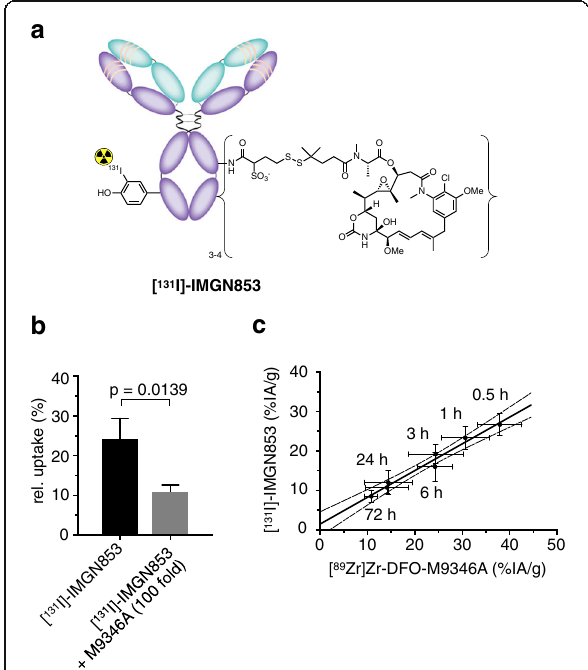
Fig. 4 Pharmacokinetic head-to-head comparison between antibody-drug-conjugate, IMGN853 and companion diagnostic, [ 89 Zr]Zr-DFO-M9346A. a Introduction of the radionuclide I-131 by direct halogenation of the antibody in the presence of Iodogen as chemical oxidant yielding radiolabeled antibody-drug-conjugate [ 131 I]-IMGN853 (32.2 MBq, 0.87 mCi, 250 μ g) in high radiochemical purity (> 98%). b In vitro characterization of [ 131 I]-IMGN853. Incubation of KB cells with radiolabeled ADC or with a mixture of radiolabeled ADC (100 ng) and M9346A (10 μ g). c Comparison of blood half-lives of [ 131 I]-IMGN853 and [ 89 Zr]Zr-DFO-M9346A (dashed line indicates the 95% confidence